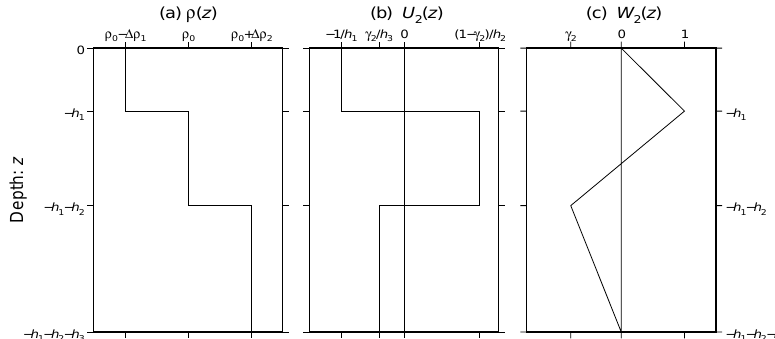
Fig. 5. The left (a) , middle (b) , and right (c) panels represent the mode-2 ISW vertical density profile ( ρ ) and vertical structure functions of horizontal ( U 2 ) and vertical ( W 2 ) current components, respectively, in the three-layer rigid-lid